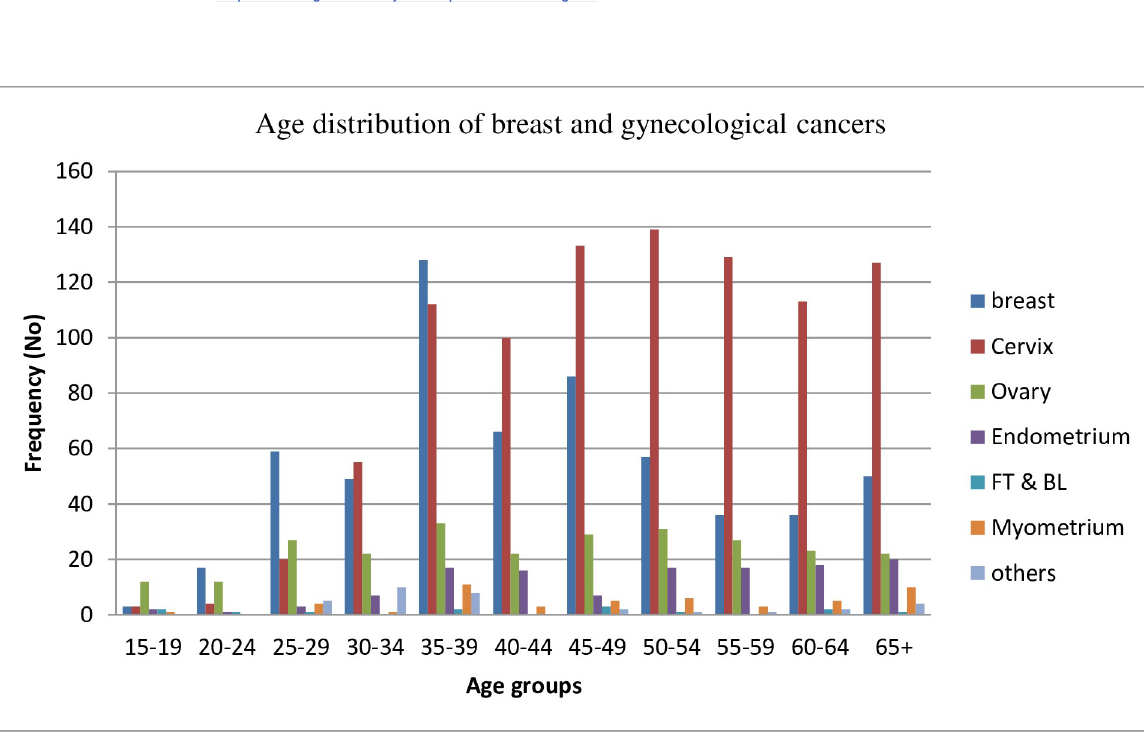
PLOS ONE | https://doi.org/10.1371/journal.pone.0230625 March 20,